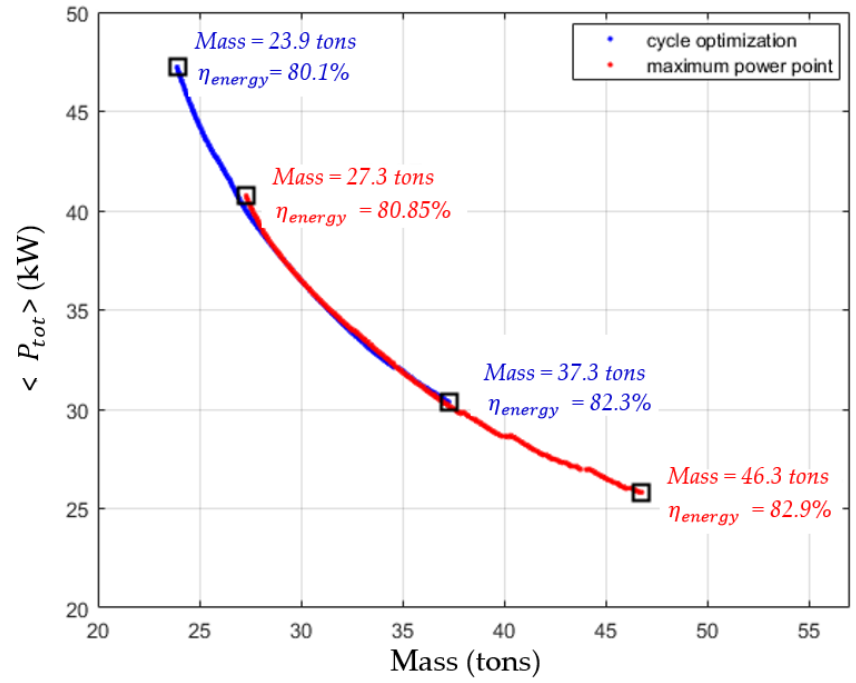
Figure 9. Pareto optimal fronts (cycle optimization and maximum power point optimization).